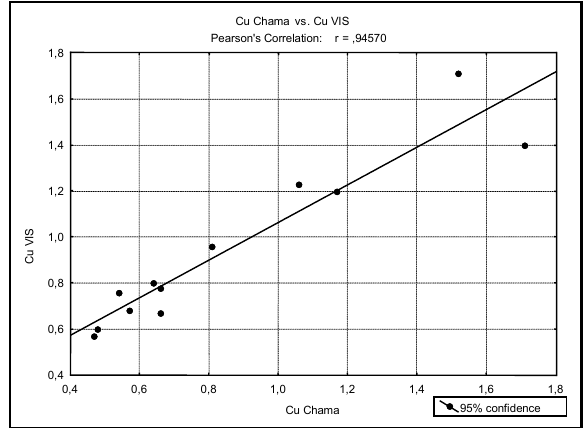
Figura 1. Correlação entre os métodos espectrofotometria e EAA-chama